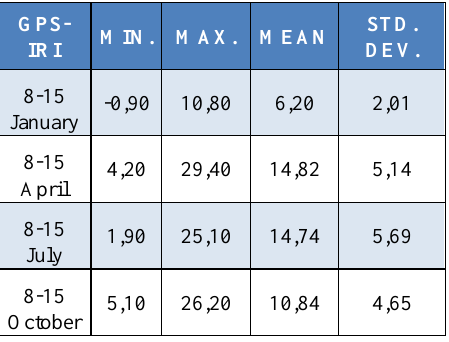
Table 3. Comparison of GPS-IRI TEC Values